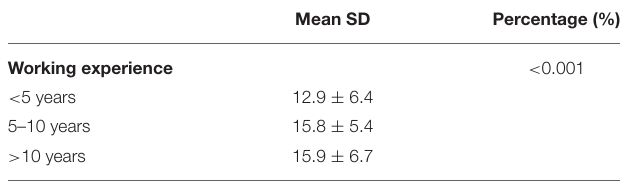
TABLE 7 | Association of participant’s demographics with knowledge